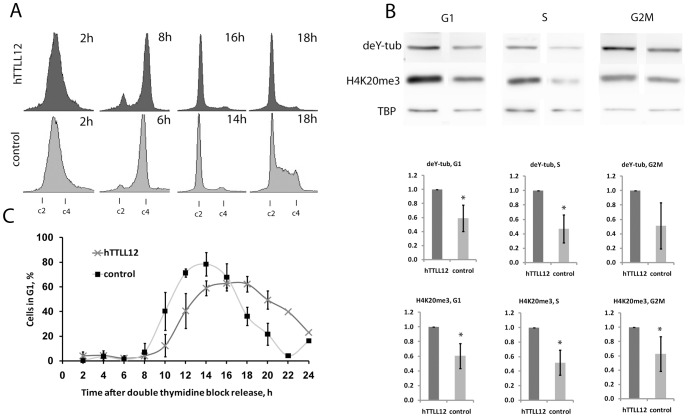
Cell cycle phase dependence of the levels of detyrosinated tubulin (deY-tub) and H4K20me3 in clones overexpressing hTTLL12 compared to control clones.
A. FACS scans of cells released from a double thymidine block at the indicated times. The times shown are those at which the cells were predominantly in S, G2/M and G1, except for the 18 hour time point. One representative synchronisation is shown. B. WBs, from one experiment, of whole cell lysates from cells synchronised in the G1, S and G2/M phases, respectively. The graphs are the averages from 3 independent experiments. * p<0.05. C. Proportion of cells in G1 at different times after release from double thymidine block. The average from 3 different experiments (up to 18 h) is shown. c2, c4 = DNA complements as measured by propidium iodide.